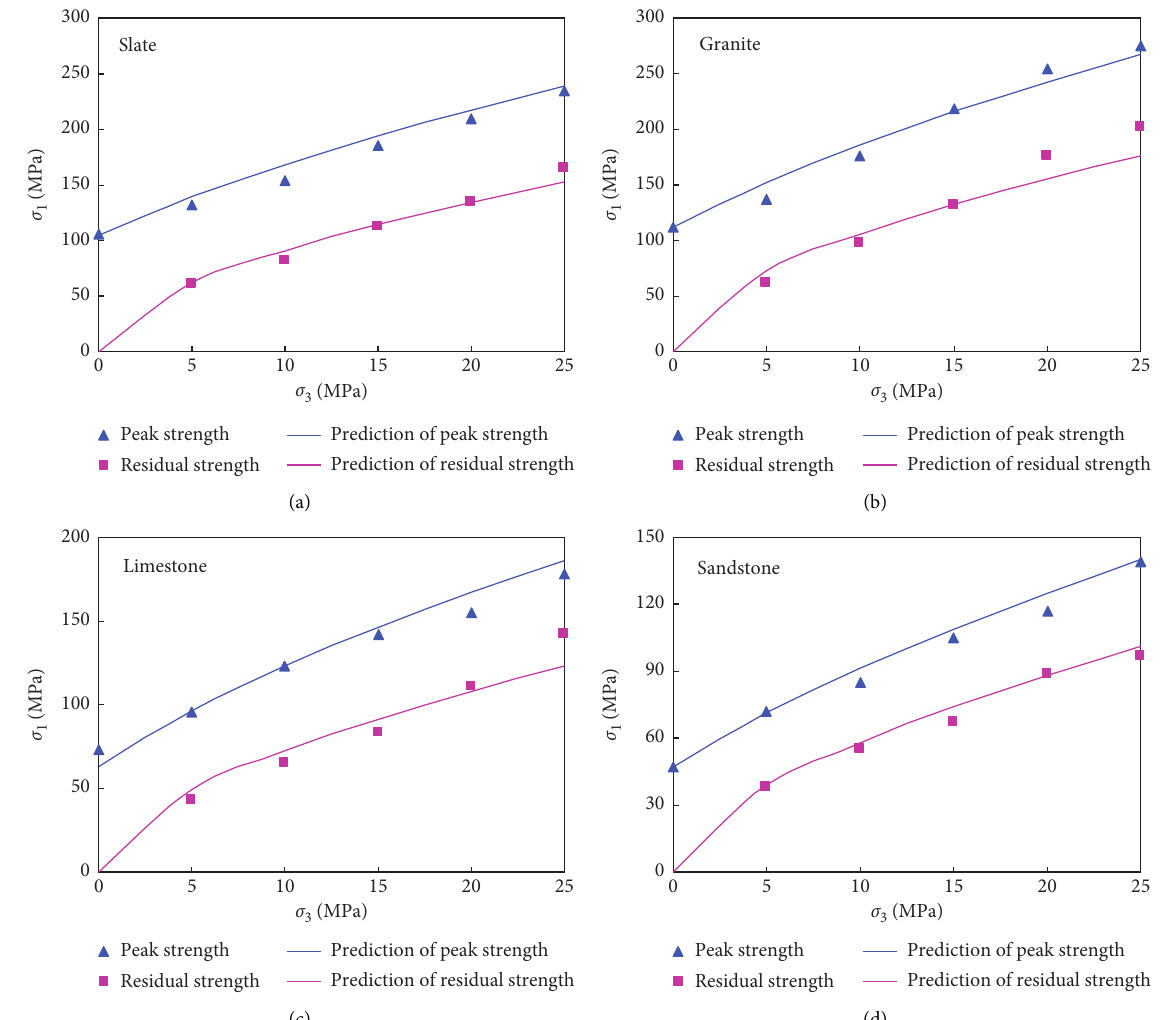
Figure 7: The peak and residual strength data of slate, granite, red sandstone, and